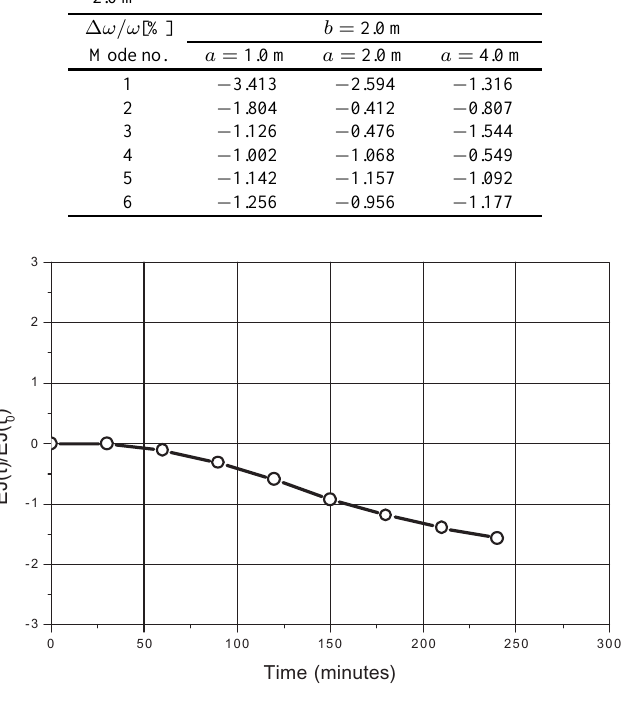
Table 4 Cantilevered beam: Eigenpulsation variations for b =